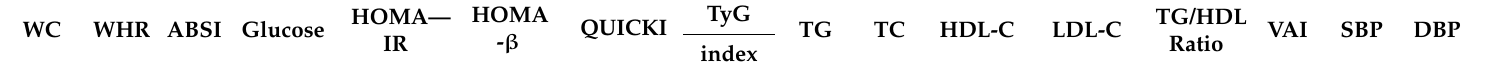
Table 3. Correlation heatmap of adiposity indices, glyco-metabolic indices, lipids, TG/HDL-C ratio, VAI and blood